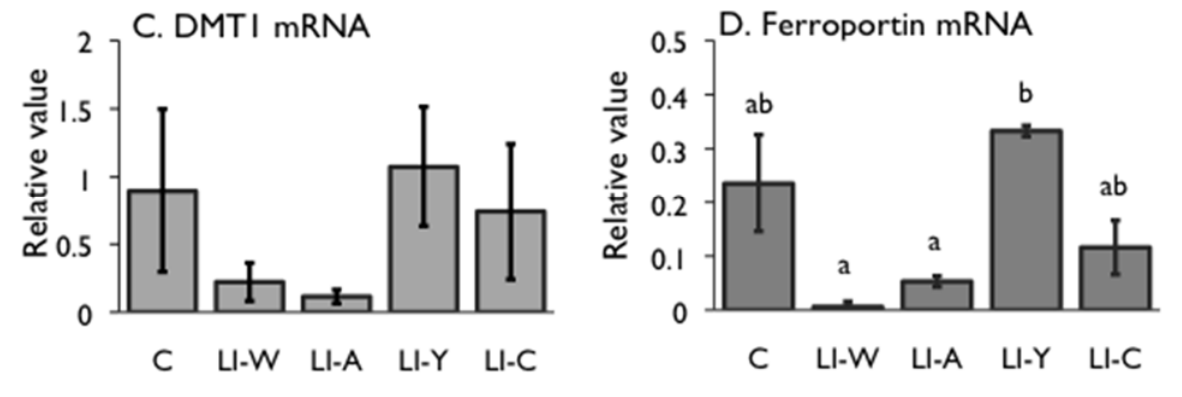
Figure 2. Iron content ( A ) and hepcidin mRNA expression ( B ) in the liver, and